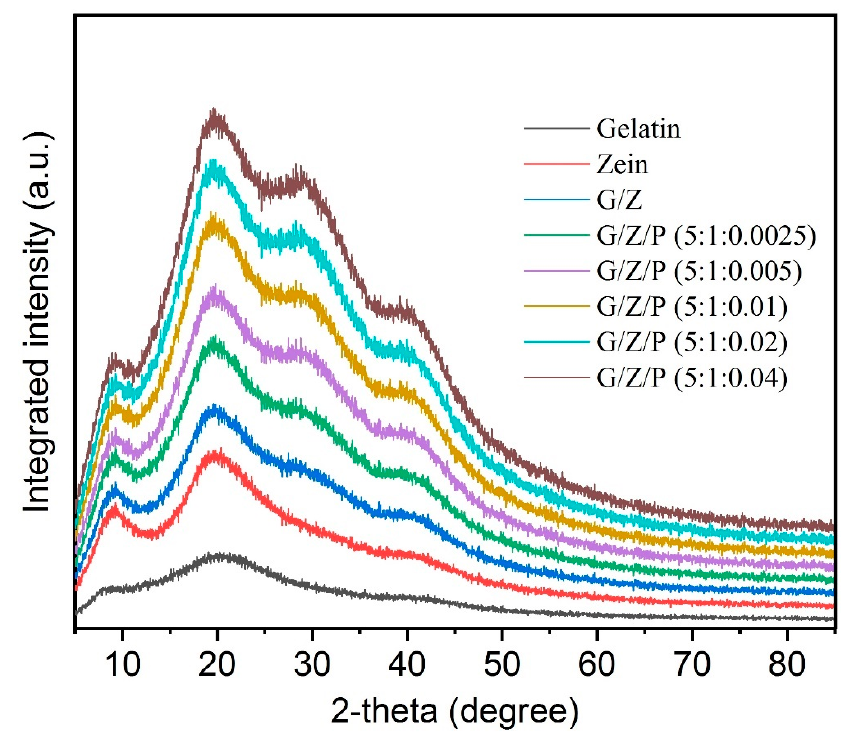
Figure 5. X-ray profiles of the gelatin/zein/perillaldehyde nanofiber films.